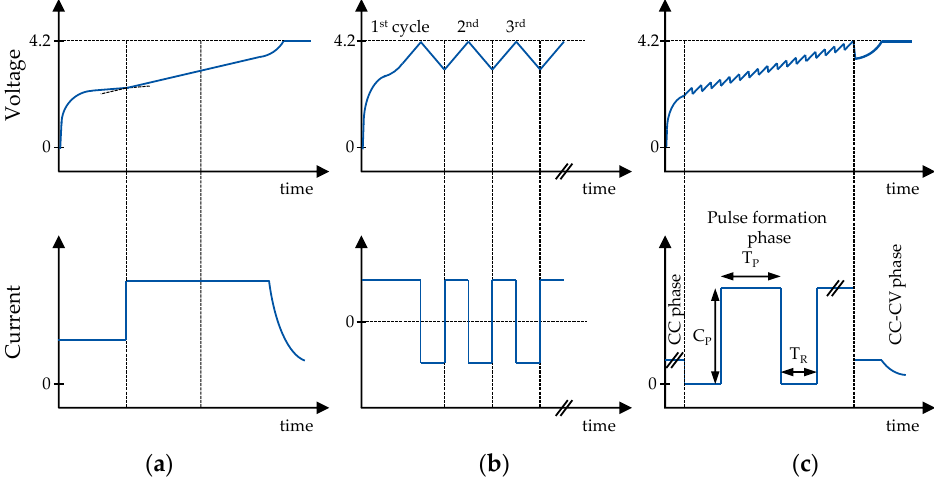
Figure 9. Current-over-time and voltage-over-time curves for respective formation protocols (authors’ illustration). ( a ) Dual-current formation [79], ( b ) Shallow-cycling-formation [48], ( c ) Pulse formation [4].